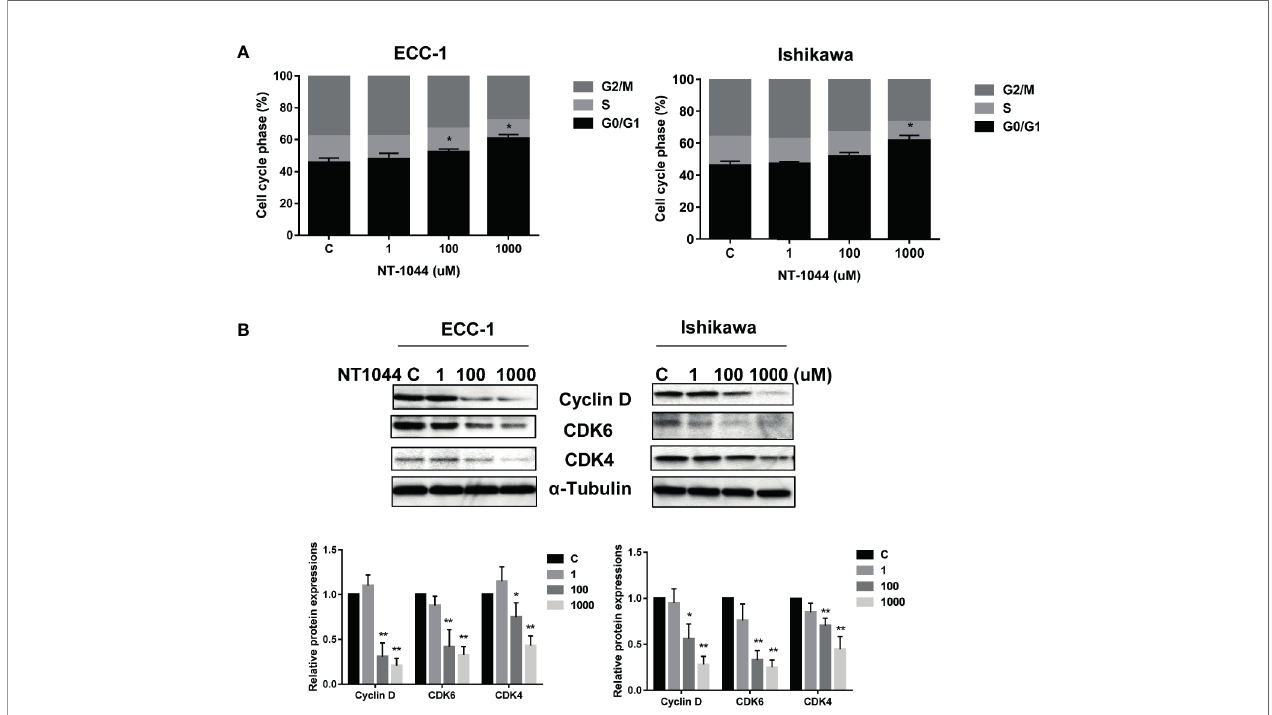
FIGURE 2 | NT-1044 induced cell cycle G1 arrest in EC cells. The ECC-1 and Ishikawa cells were treated with NT-1044 for 24 hours. Cell cycle progression was assessed by Cellometer. NT-1044 induced cell cycle G1 arrest in a dose-dependent manner in both cell lines (A) . Western blotting showed that NT-1044 decreased the expression of CDK4, CDK6 and cyclin D in a dose-dependent manner in both cell lines after 24 hours of exposure (B) . *p < 0.05, **p <